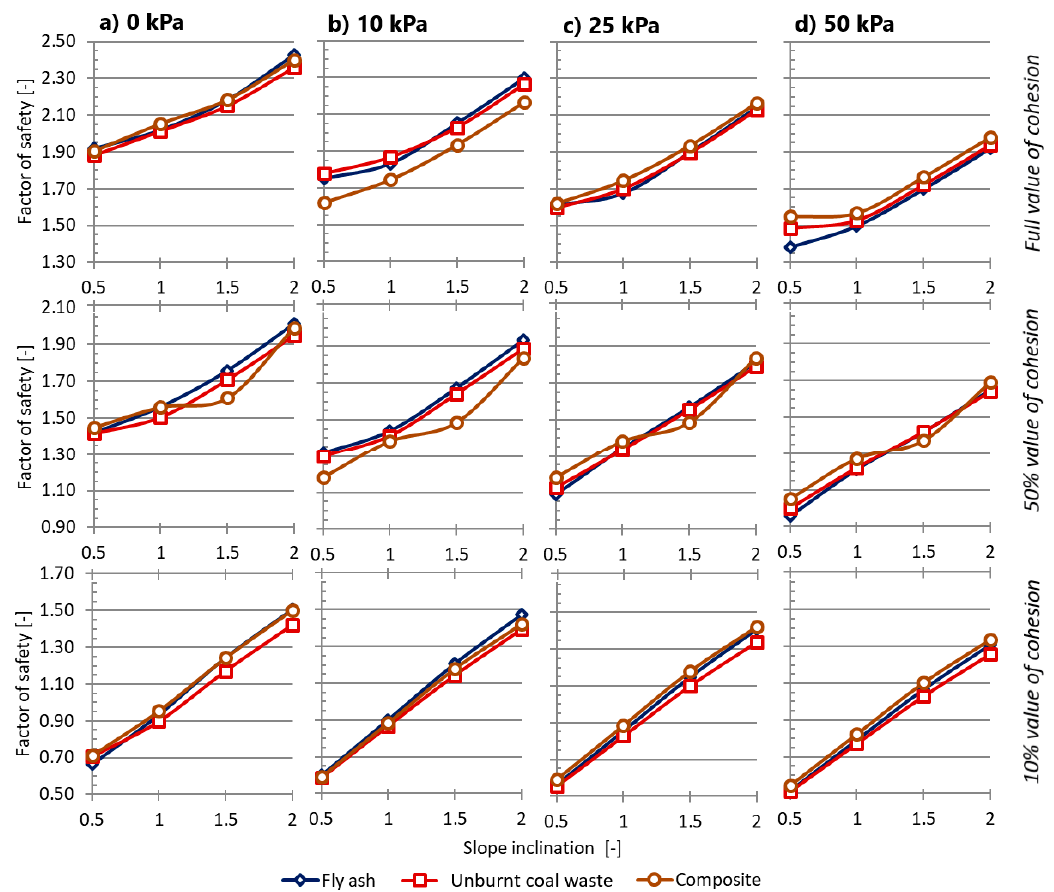
Figure 10. Changes in the factor of safety with decreasing inclination at a given load on the embankment.